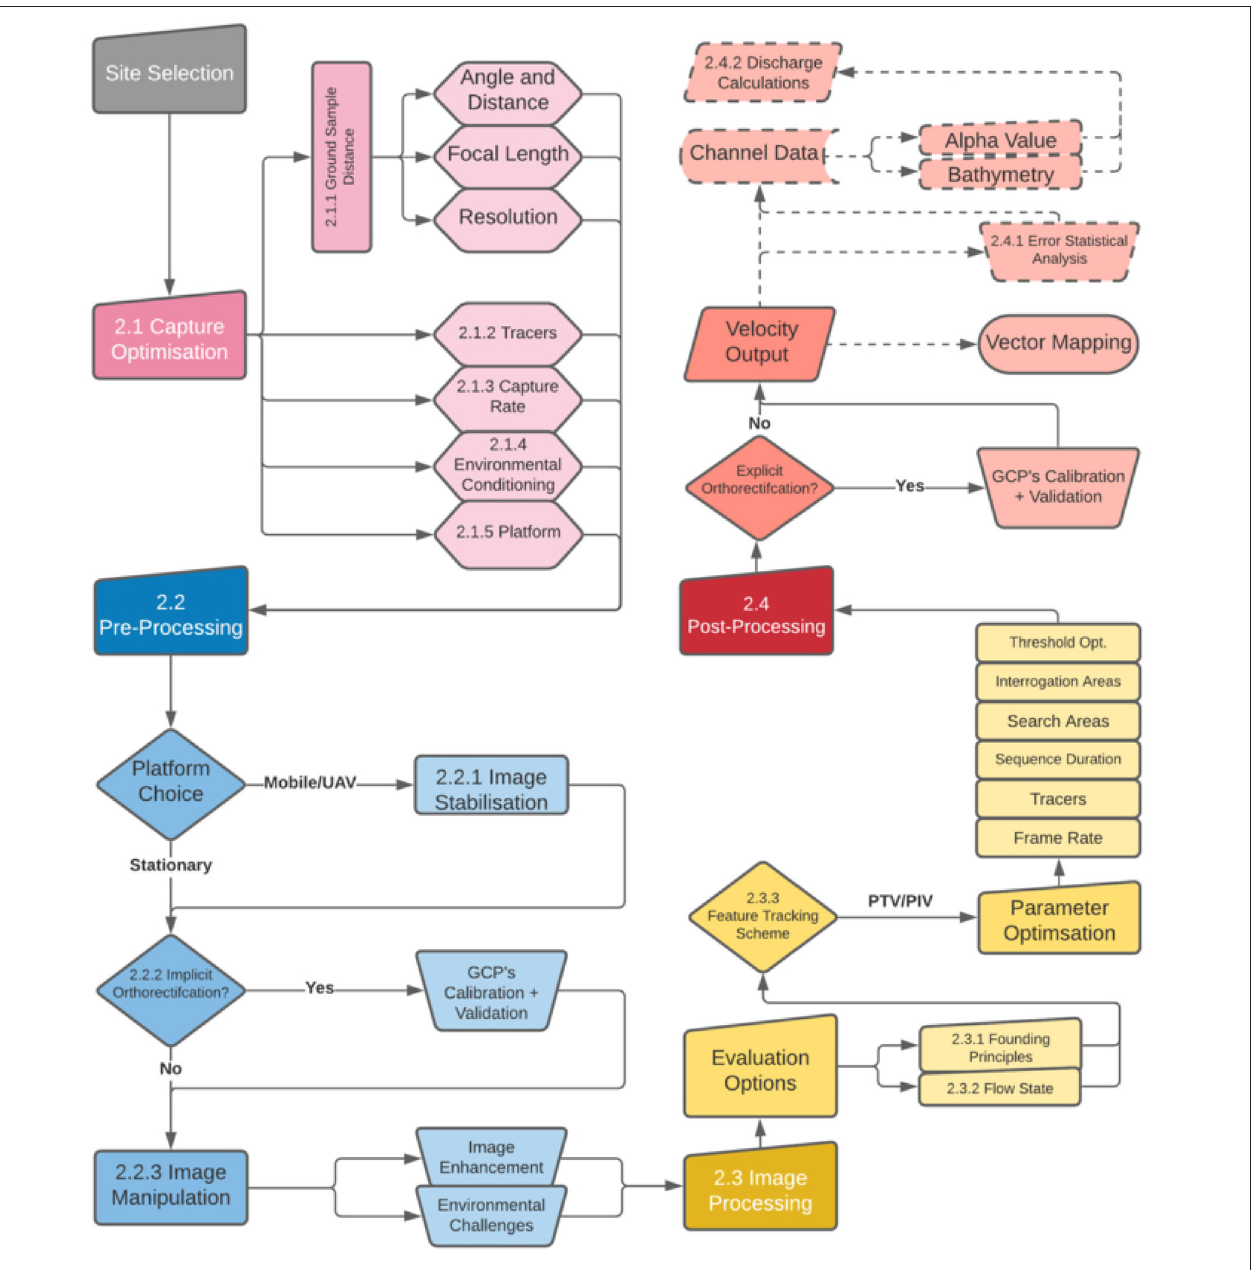
FIGURE 2 | A generalised system of the required processes for analysing river flow using image velocimetry methods. Pink sections are the steps required for capture optimisation (section 2.1), blue represents pre-processing stages (section 2.2), yellow the processing stages (section 2.3), and red shows post-processing stages (section 2.4) (Harpold et al., 2006; Koutalakis et al., 2019; Perks, 2020).